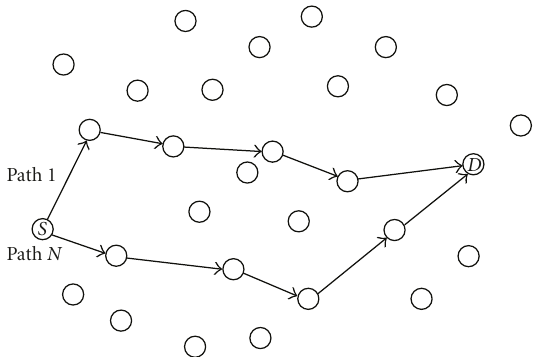
Figure 1: A typical multihop wireless ad hoc network.